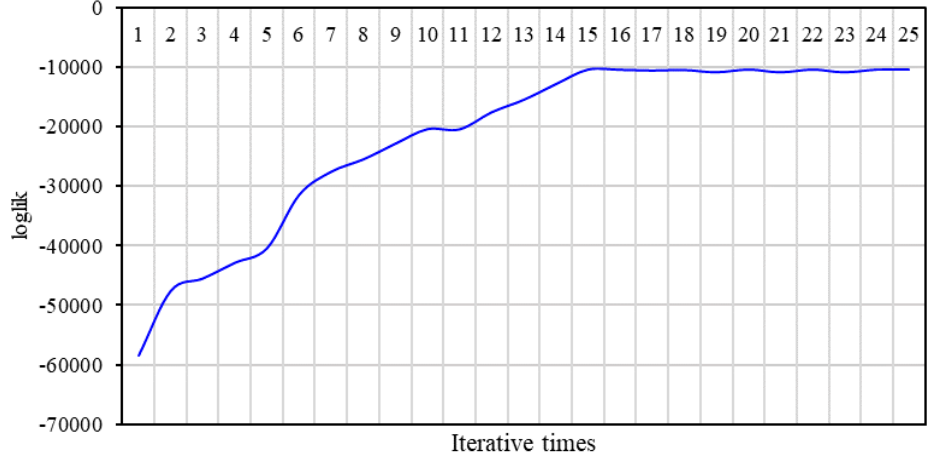
Figure 8. Iterative curve of expectation maximization (EM) algorithm. Table 7. The transition probability distribution of node WVHT.